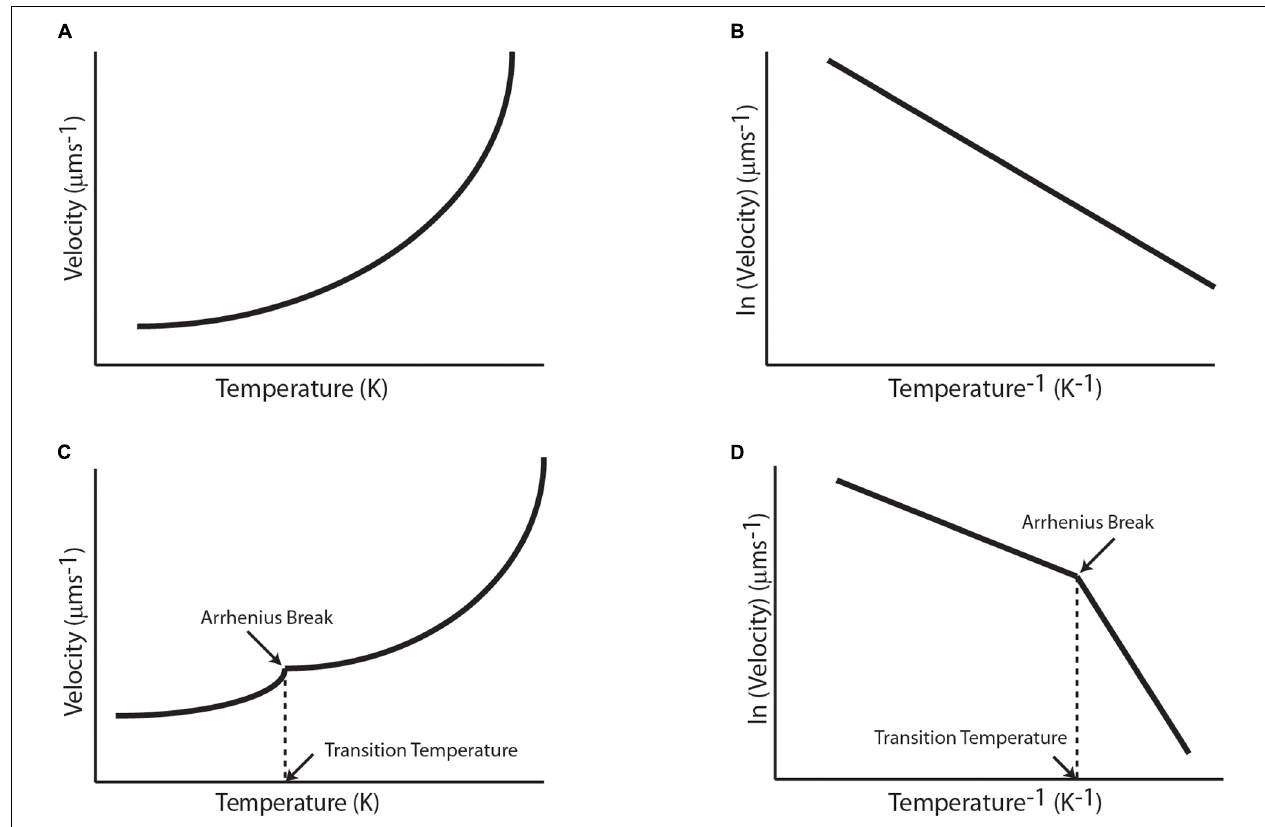
FIGURE 2 | Qualitative graphical representation of reported temperature dependence of biophysical and biochemical properties of molecular motors with temperature for (A) A simple Arrhenius enzyme, (B) corresponding Arrhenius plot of a simple Arrhenius enzyme, (C) A complex Arrhenius enzyme, and (D) corresponding Arrhenius plot of a complex Arrhenius